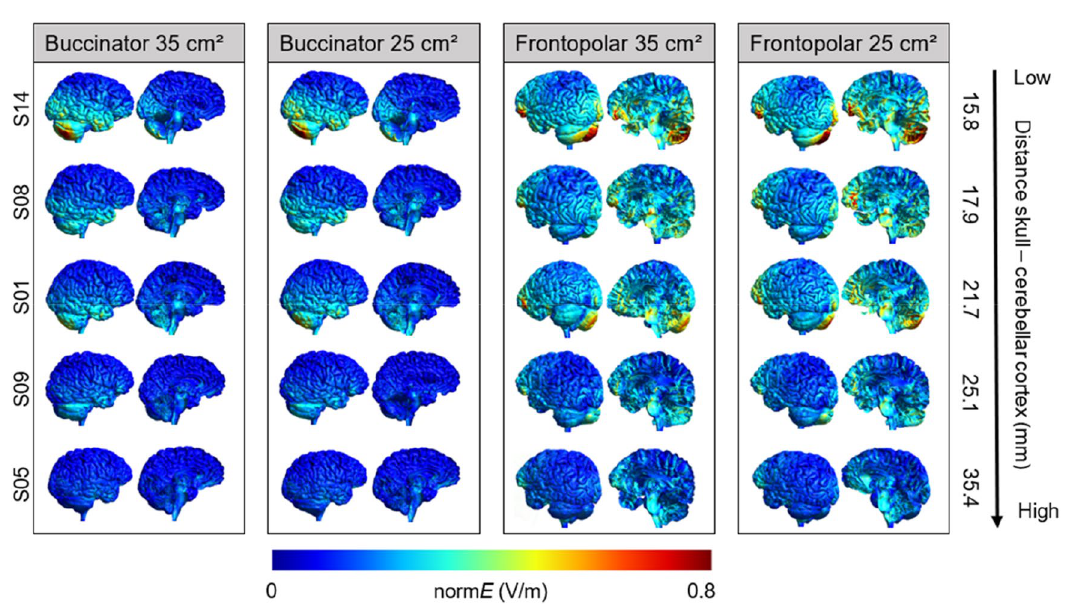
Figure 2. Field strength (normE in V/m) for the four conventional electrode montages. Individual electric fields are depicted for five individuals representative of the range of scalp–cortex distances. An illustration of individual electric fields of all individuals included in the study can be found in the “Supplementary Materials” (Fig.